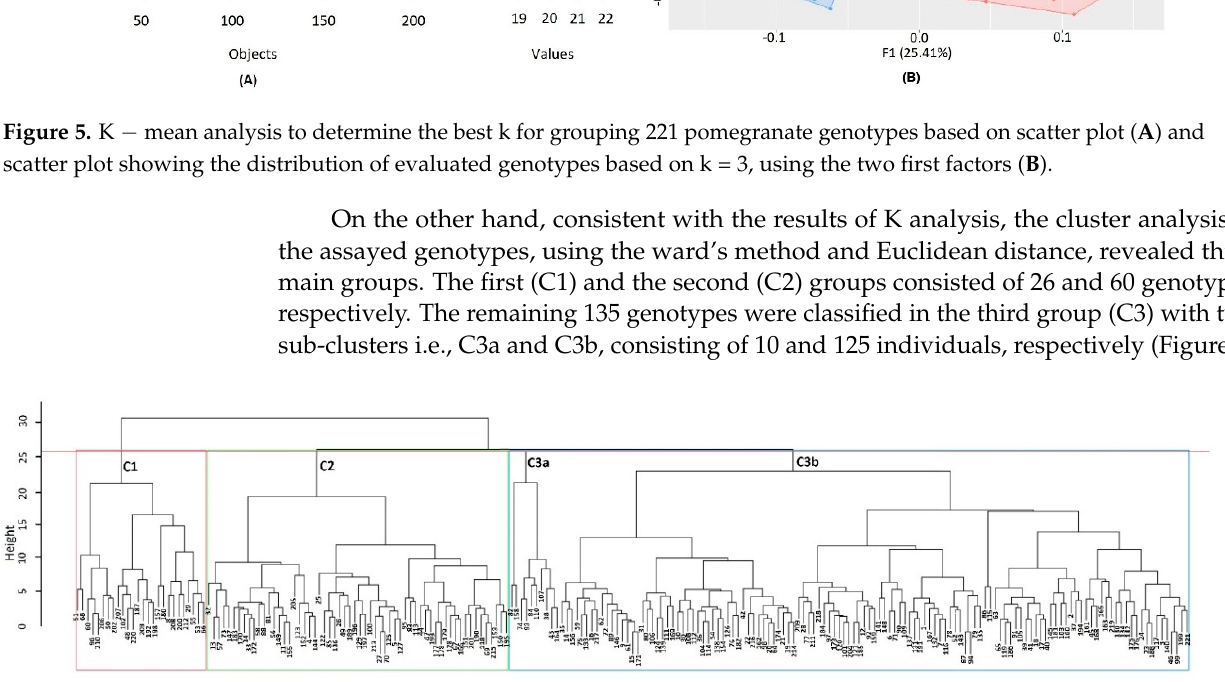
Figure 5. K − mean analysis to determine the best k for grouping 221 pomegranate genotypes based on scatter plot ( A ) and scatter plot showing the distribution of evaluated genotypes based on k = 3, using the two first factors ( B ).